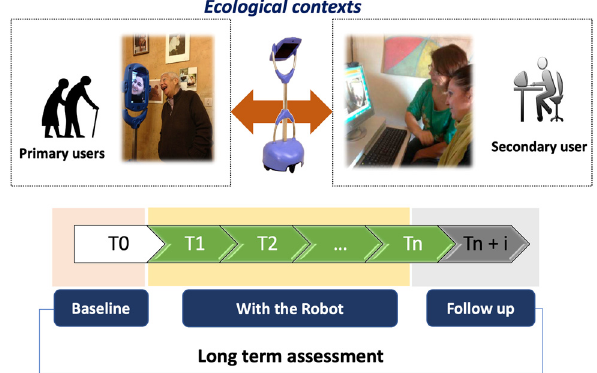
Figure 4: The E X CITE project: testing a telepresence robot in ecolo - gical settings and with a long term